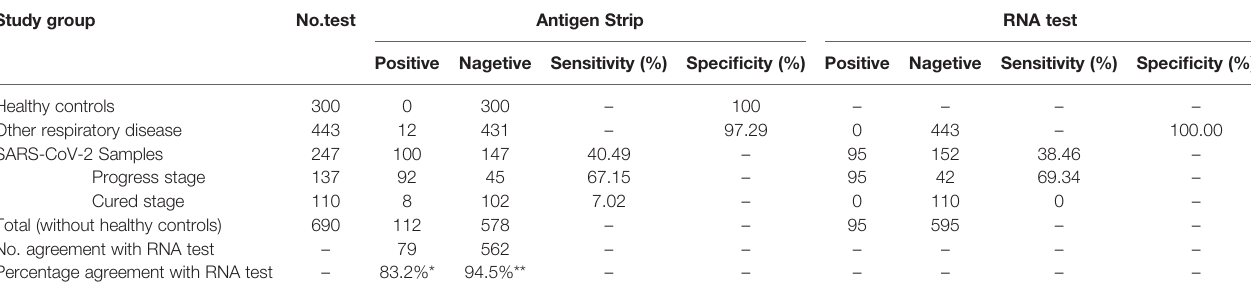
TABLE 5 | The speci fi city and sensitivity of test